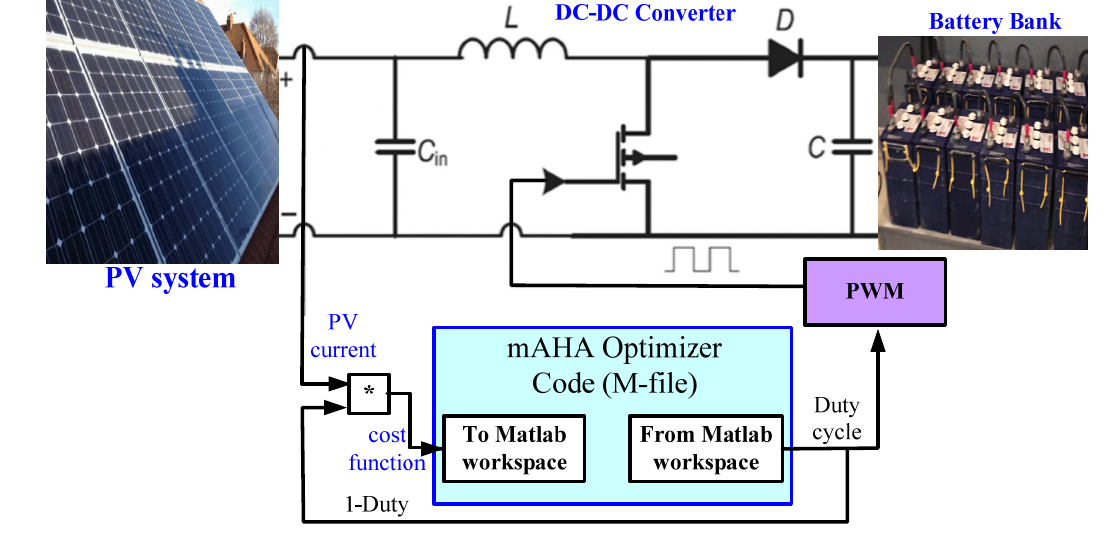
Figure 4. Schematic diagram for PV system with MPPT. Table 4. Specifications of the PV system.